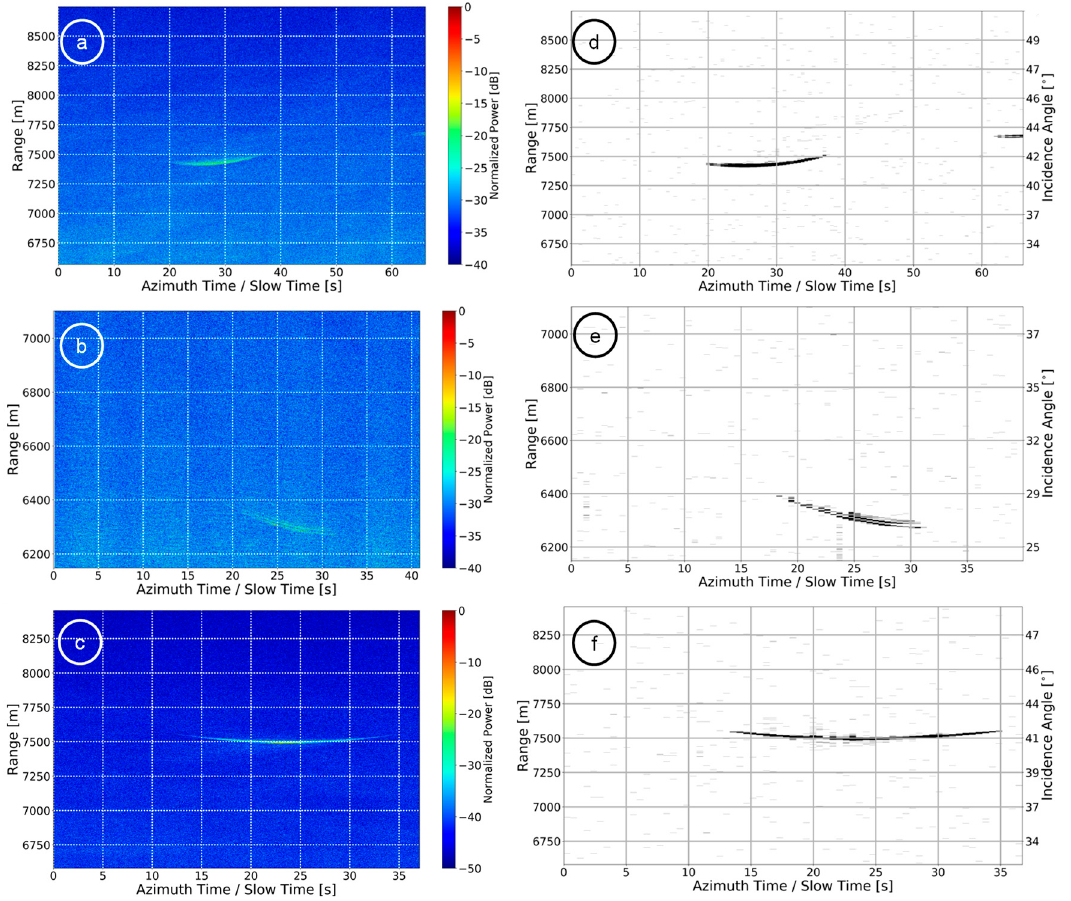
Figure 32. RC F-SAR X-band VV polarized radar data with a ship moving at ( a ) 45 ◦ , ( b ) 90 ◦ and ( c ) 0 ◦ w.r.t the flight track. The detection results corresponding to ( a – c ) are shown in ( d – f ) respectively. Only the K-Rayleigh distribution was used for detection because the maximum incidence angle in the data is below 50 ◦ . The desired false alarm rate was set to P fa = 10 − 6 .